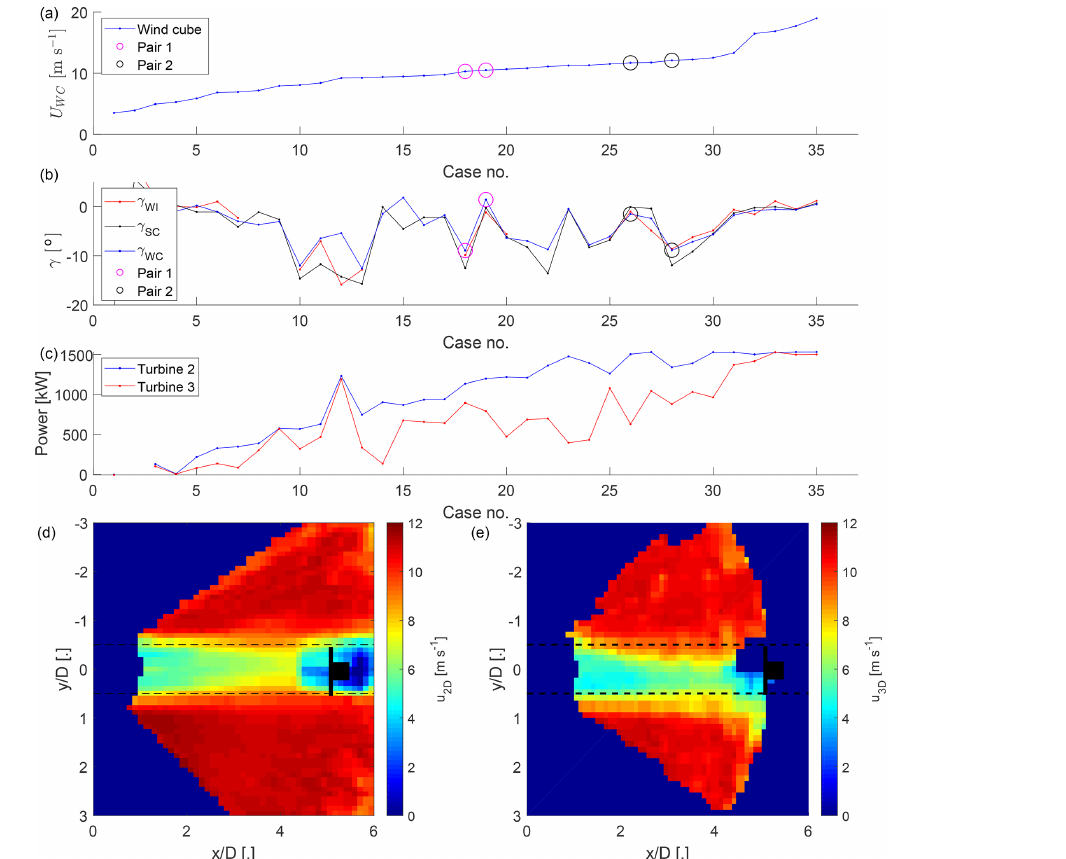
Figure 12. The inflow wind speed (a) , the yaw angle of T2 (b) , and the power (c) for all 30min periods with the wind direction aligned with the downwind turbine within 1 ◦ sorted by wind speed (data filtering of Sect. 2.3.1 not applied). Highlighted with circles are the two pairs with similar wind speed and wind direction and all measurement data available but different yaw angles. The two bottom panels show the mean longitudinal velocity fields at hub height from the wake-scanning Doppler lidar for the first pair with the non-yawed case (d) and the yawed case (e) . The rotor area shadow of T2 is indicated as a dashed black line, and the position of T3 is stylized in